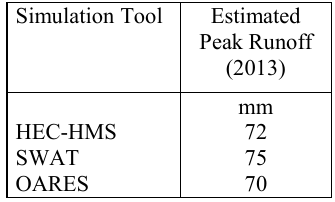
Table 1. Comparison of Model